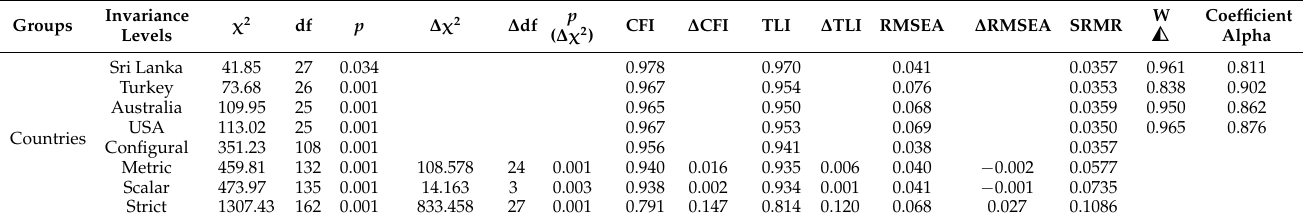
Table 2. Goodness-of-fit indices for the one-factor structure of the Internet Gaming Disorder Scale 9—Short form (IGDS9-SF) among university students from Sri Lanka, its invariance across countries, normality tests, and internal consistency.